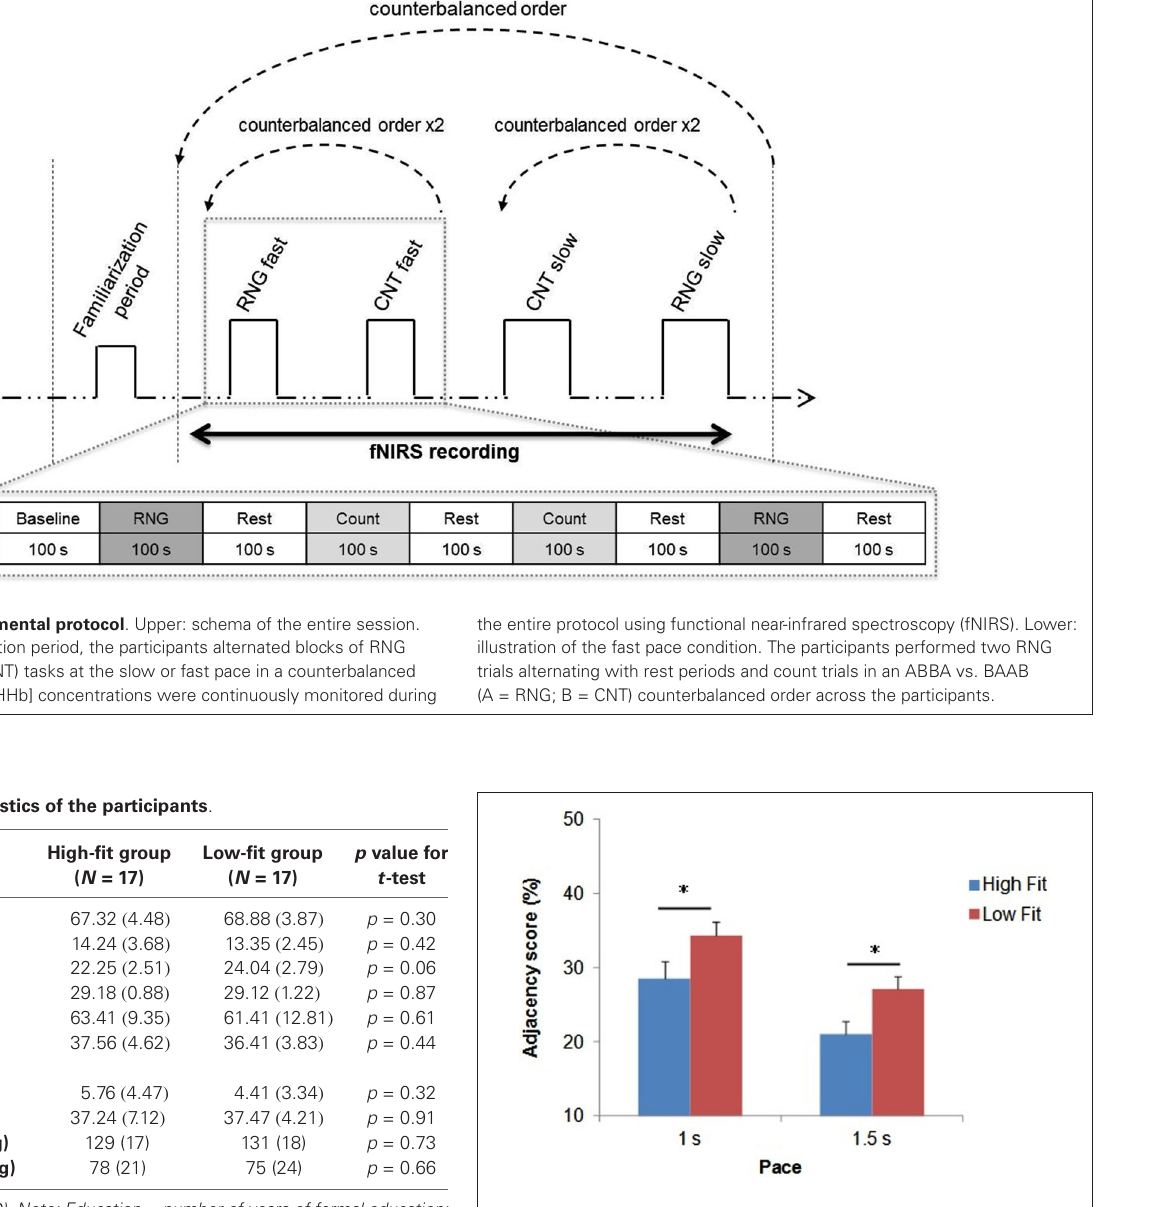
FIGURE 2 | Mean Adjacency score (in %) as a function of group and pace . Bars represent standard-errors. * p < 0.05.